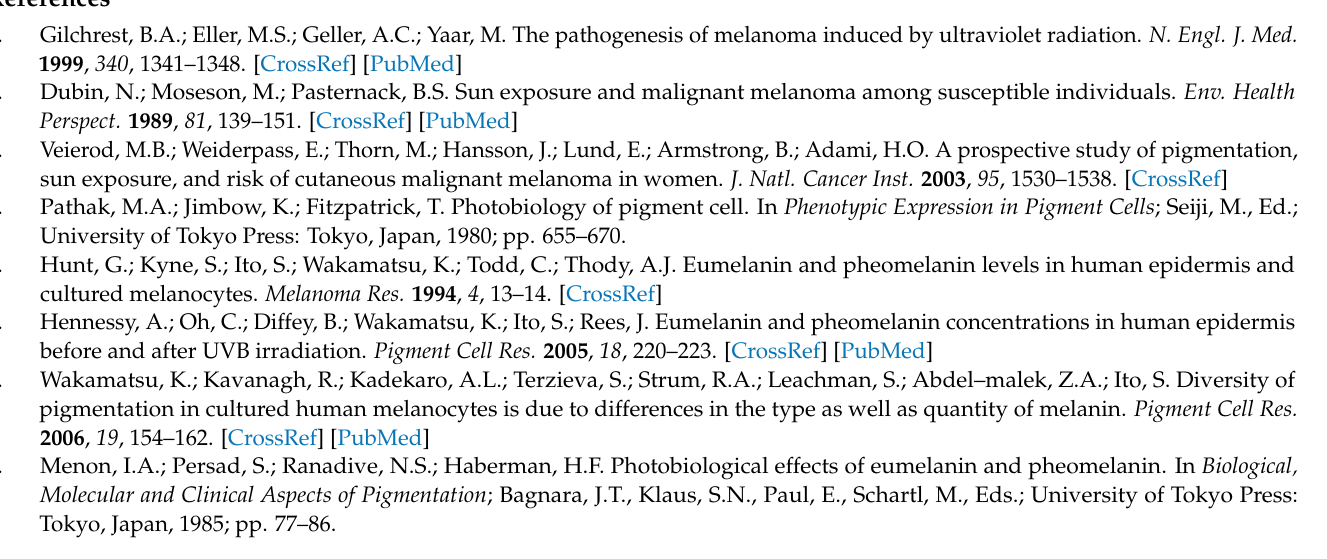
Figure S2: Densitometry analysis of the Western blot data presented in Figure 4. Figure S3: Statistical analysis of the Western blot data of p53. Figure S5: Statistical analysis of the combined densitometry data of L versus D melanocyte cultures in Supplementary Figure S4. Table S1. List of primary antibodies used in the Western blot